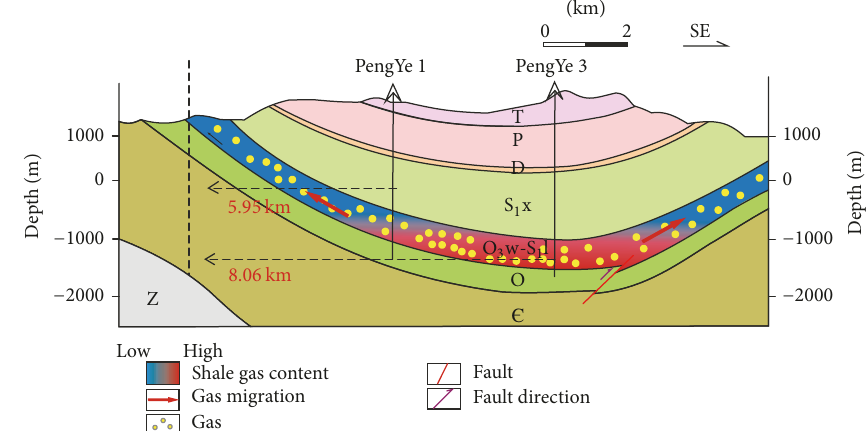
Figure 8: Shale gas accumulation diagram of the Pengshui Area, Southeast Chongqing. See Figure 1 for the location.